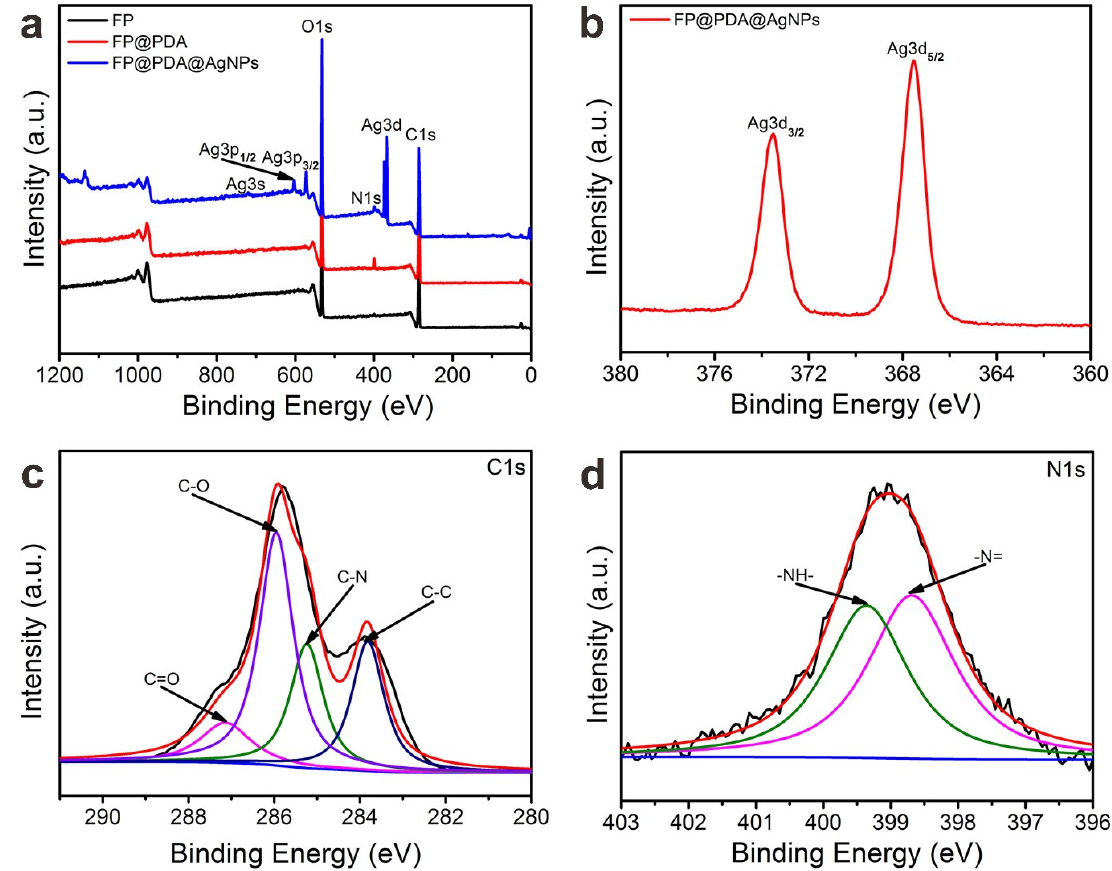
Figure 4. ( a ) X-ray photoelectron spectra (XPS) of the pristine FP, FP@PDA, and FP@PDA@AgNPs Figure 4. ( a ) X ‐ ray photoelectron spectra (XPS) of the pristine FP, FP@PDA, and FP@PDA@AgNPs strips. ( b ) Ag3d spectra of FP@PDA@AgNPs. High-resolution ( c ) C1s spectrum and ( d ) N1s spectrum strips. ( b ) Ag3d spectra of FP@PDA@AgNPs. High ‐ resolution ( c ) C1s spectrum and ( d ) N1s spectrum of the FP@PDA of the FP@PDA strips.